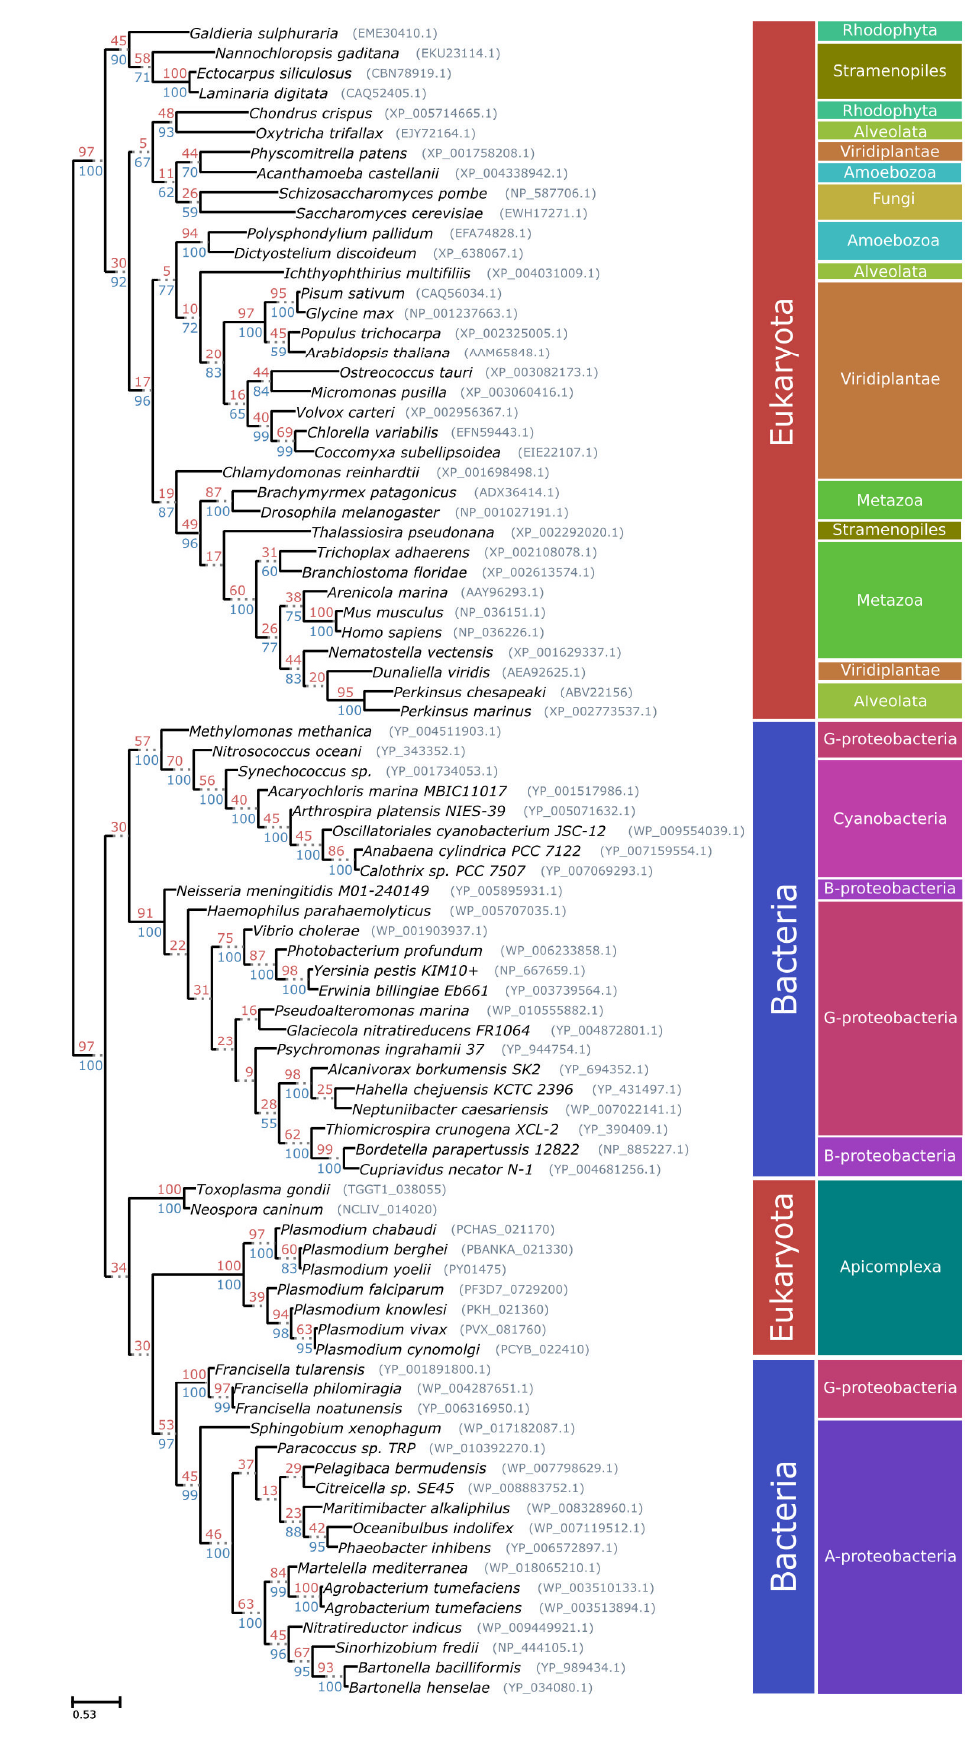
FIGURE 3: Phylogenetic tree of the Prx5 gene